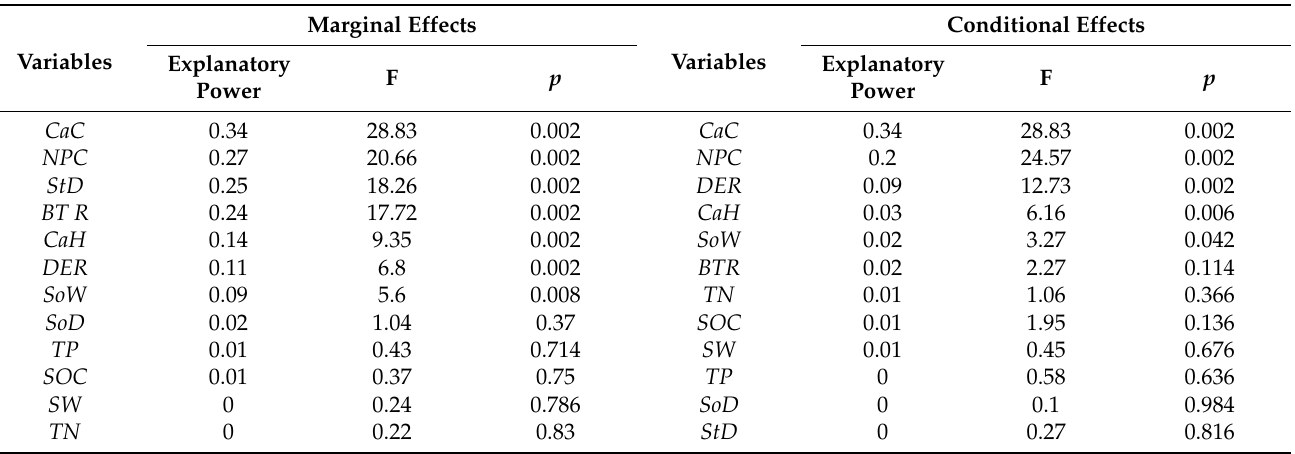
Table 7. The marginal and conditional effects obtained from the forward selection for moso bamboo